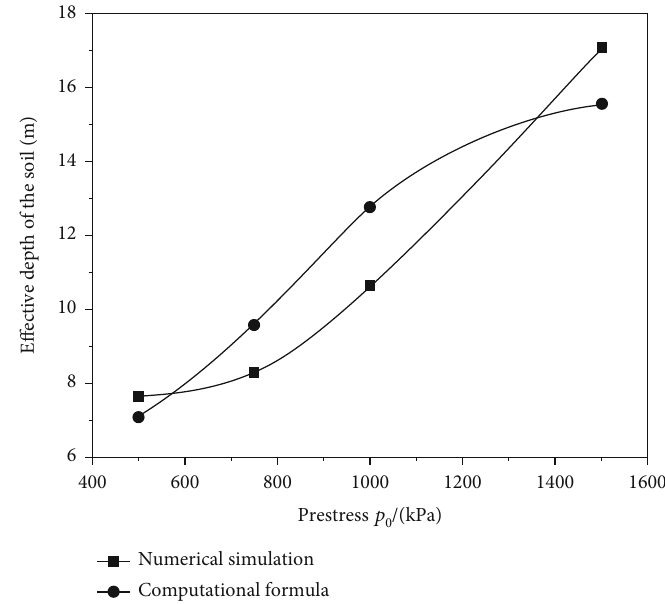
Figure 16: Maximum e ff ective depth underlying the anchor beam.